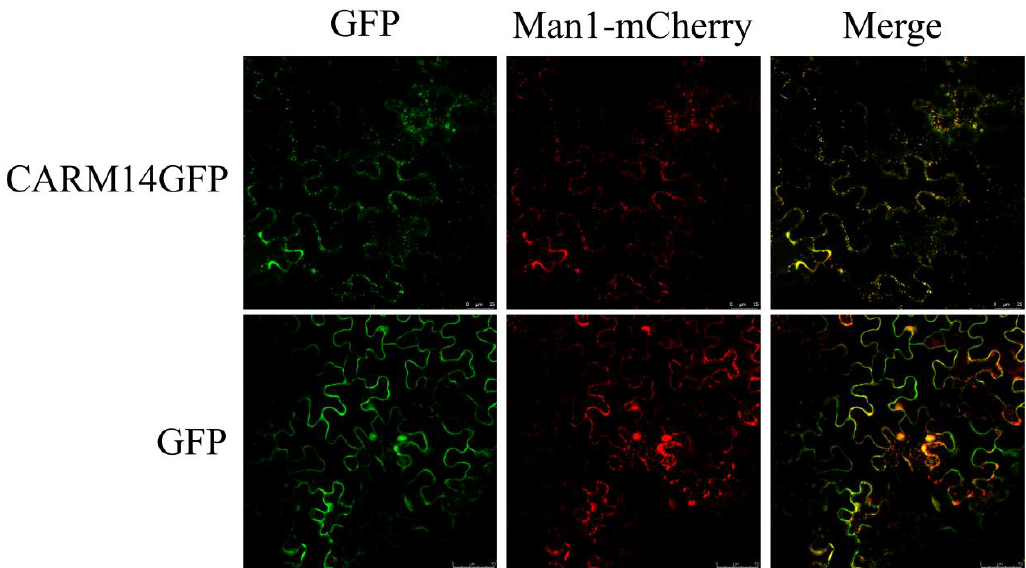
Figure 5. Subcellular localization of the CmARM14 protein. The CmARM14GFP fusion construct and GFP gene driven by the CaMV-35S promoter were transiently expressed in Nicotiana benthamiana individually. The figure shows that the CmARM14 fusion protein was completely colocalized with the Golgi marker (Man1) protein. CmARM14GFP Scale bar = 25 μm. GFP Scale bar = 50 μm.